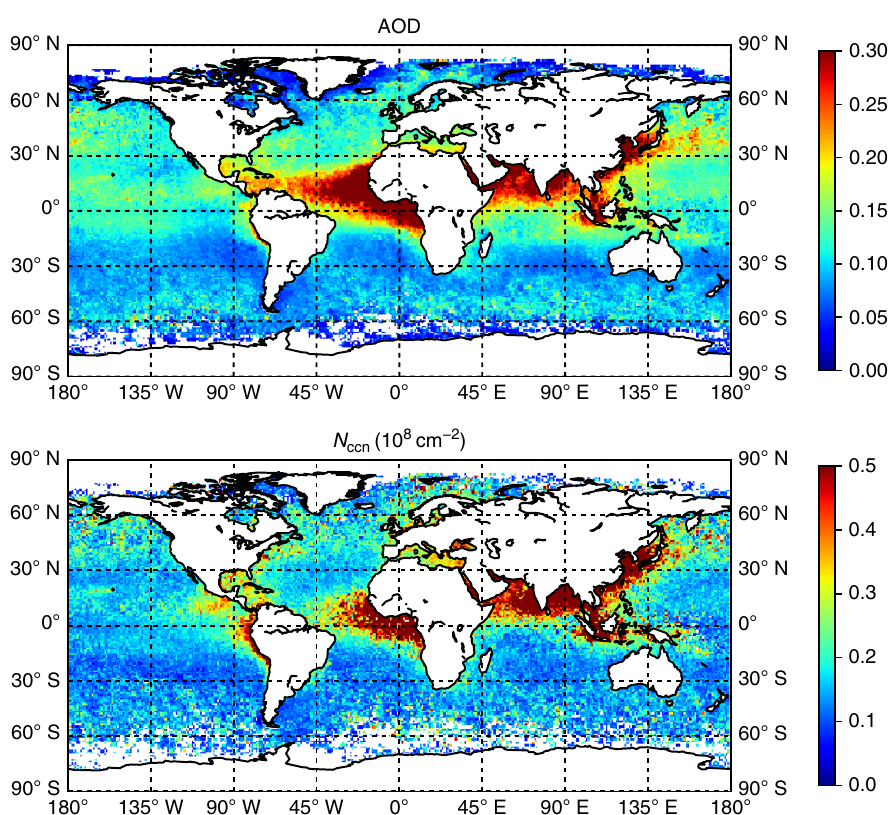
Fig. 2 Aerosol Optical Depth and CCN column number. Annual average values of the aerosol optical depth (AOD) and cloud condensation nuclei (CCN) column number ( N ) for ccn